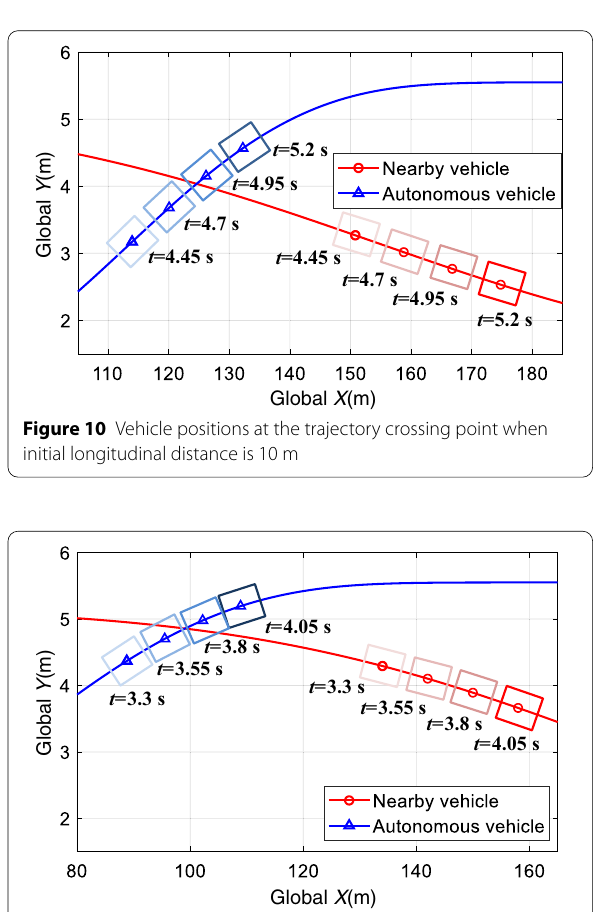
Figure 13 Yaw rate and lateral velocity of autonomous